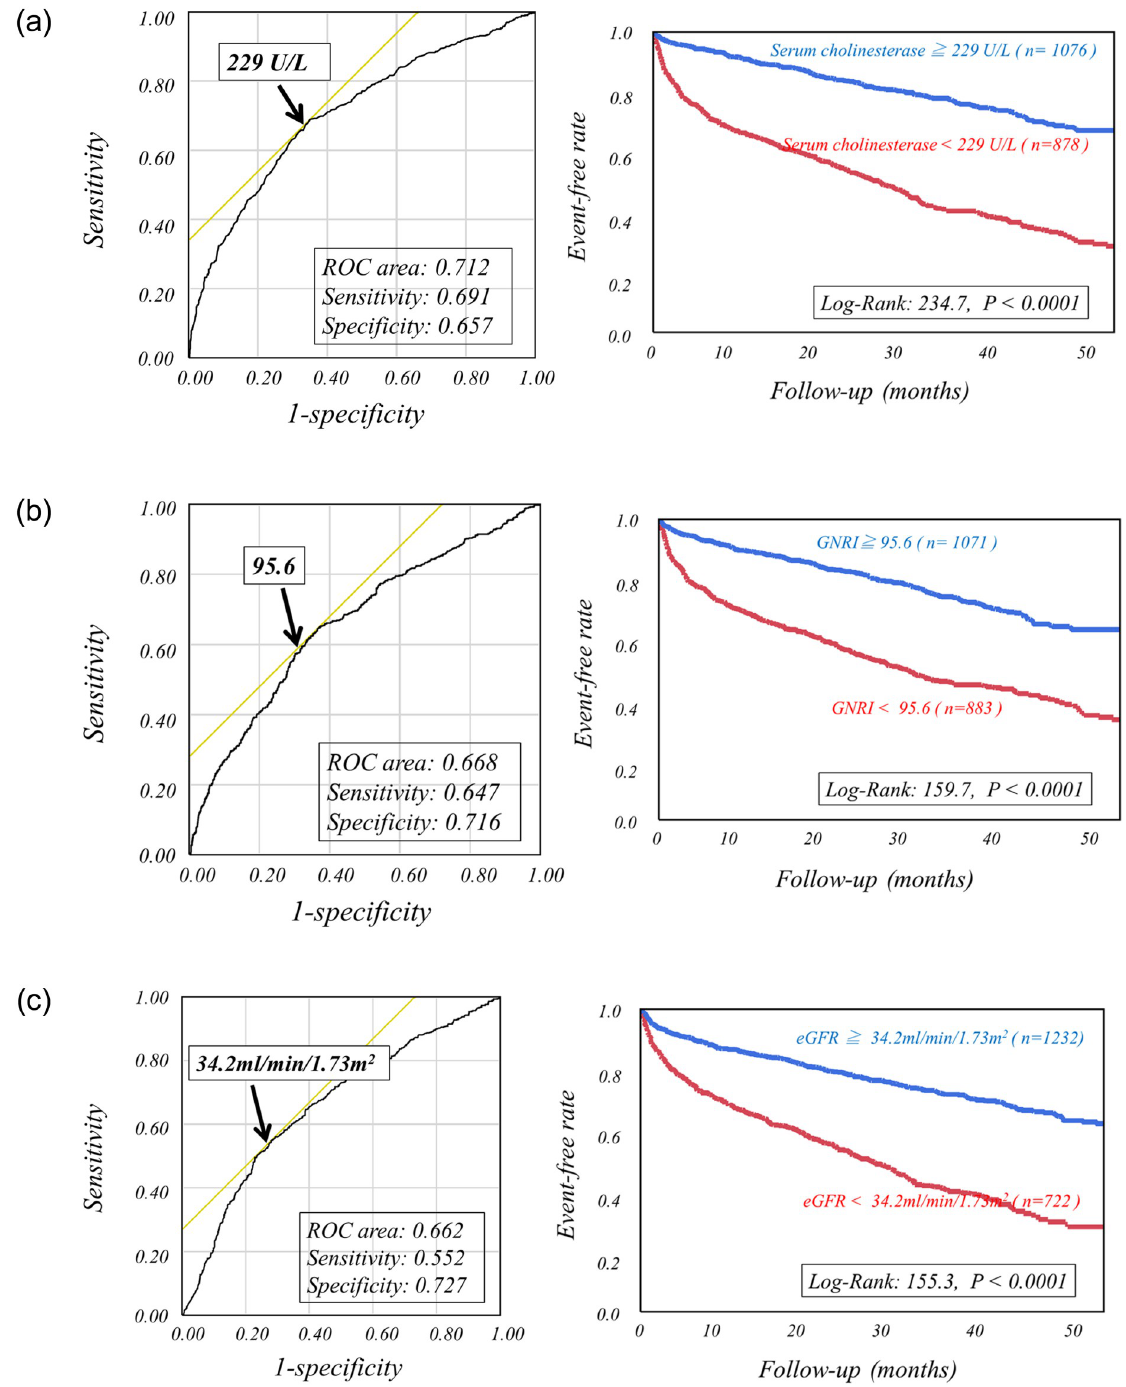
Fig 1. Kaplan-Meier event-free curves clearly discriminate high-risk patients from low-risk patients by using cutoff values determined by ROC analysis, including serum cholinesterase of 227U/L (A), Geriatric Nutritional Risk Index (GNRI) of 95.6 (B) and estimated GFR of 34.2ml/min/1.73m 2